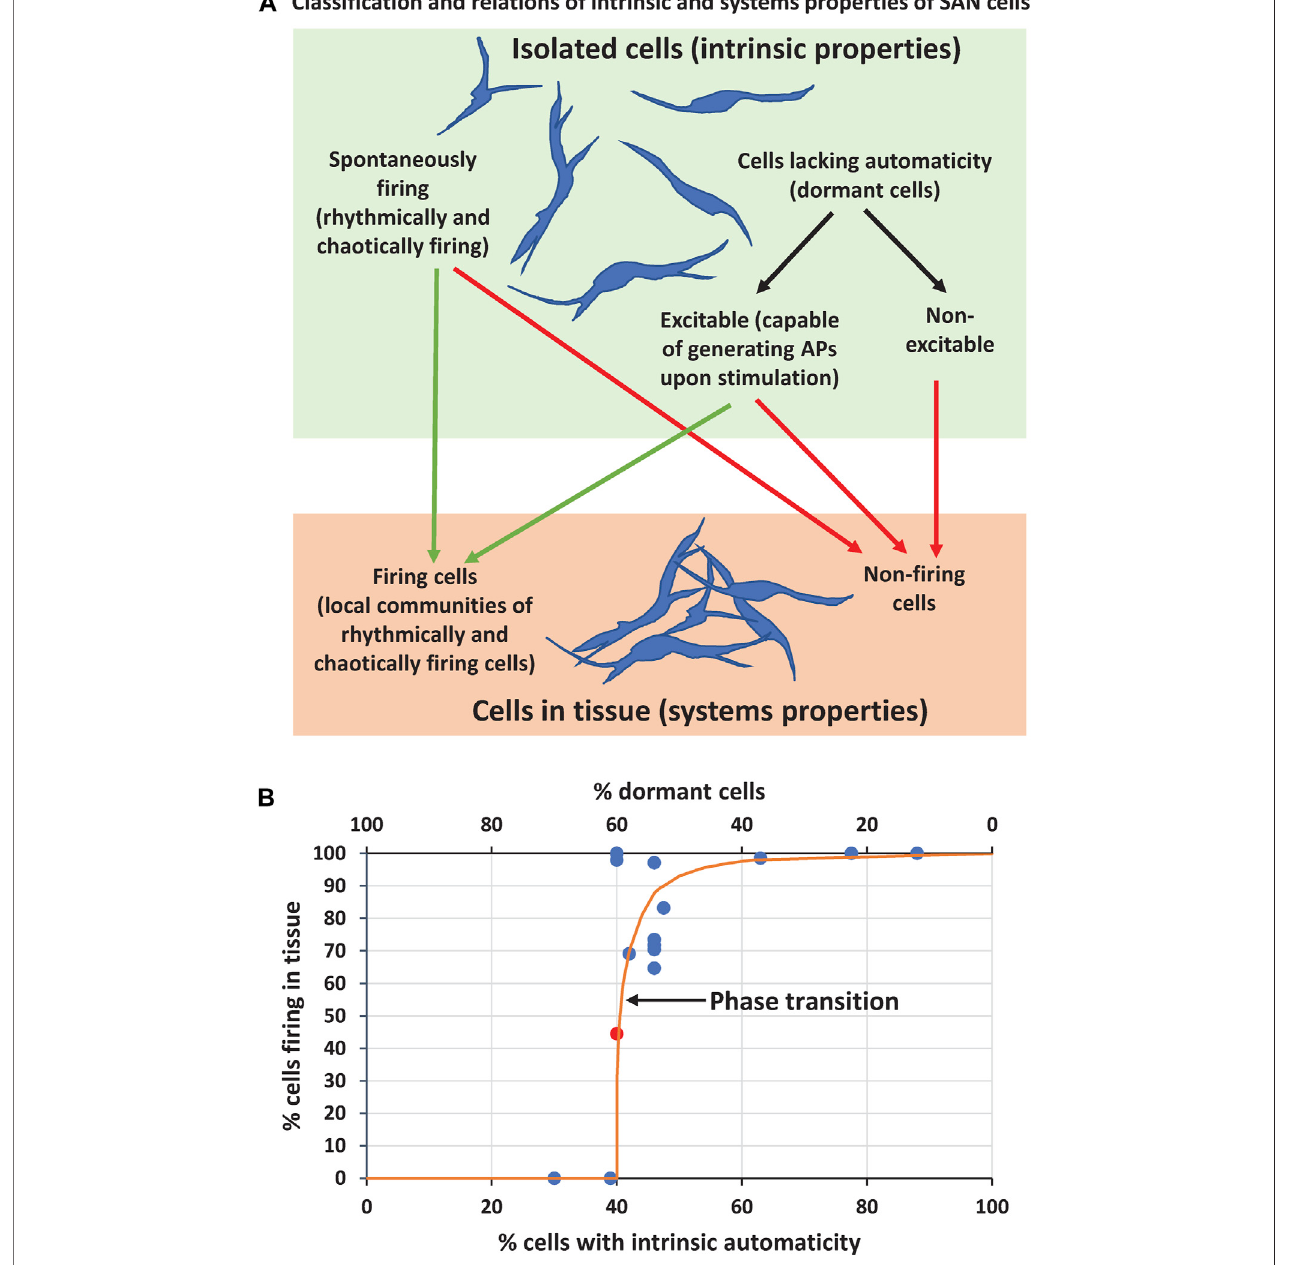
FIGURE 8 | Results summary and interpretation (A) Classi fi cation of intrinsic properties of individual SAN cells and their relation to properties of SAN cells within tissue (B) A summary graph based on data in Table 1 (except scenarios 9, 10, 13, 14) showing relation of the percentage of fi ring cells in tissuemodel as the function of percentage of intrinsically fi ring cells (bottom x axis) or dormant cells (top x axis). Orange line illustrates a hypothetical phase transition (free-hand line with no theoretical value). Note that cell tissue can function with the percentage of intrinsically fi ring cells as low as 40% (i.e. 60% of dormant cells). Red circle in the middle of the plot showsthedatapointforscenario5bre fl ectingan “ intermediate ” systemperformanceduringitsphasetransitionfrom fi ringtonon- fi ringstate(AP fi ringceasedatabout6 s, see Supplementary Movie S5B